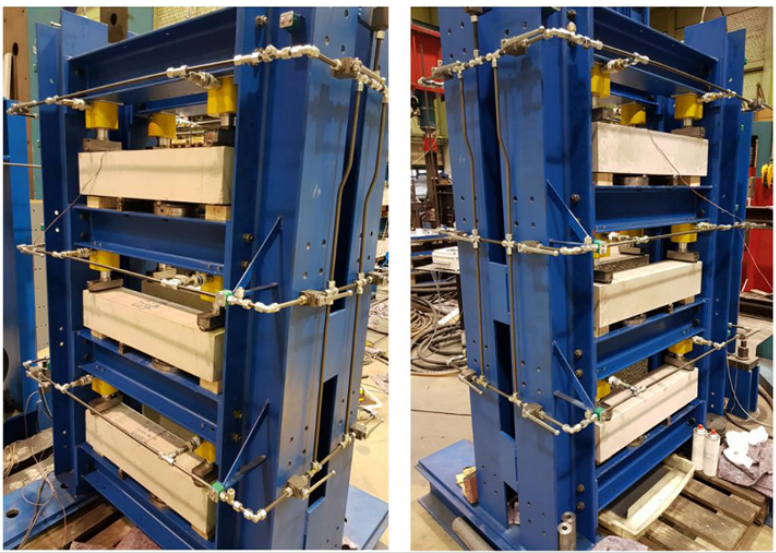
Figure 5. Test setup for the simultaneous loading of six